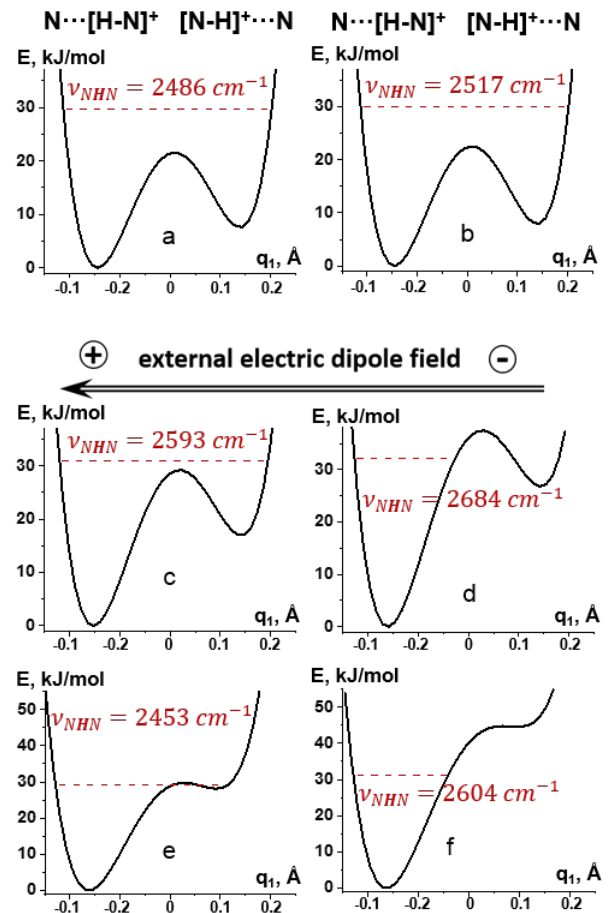
Figure 3. Potential energy curve of a proton transfer within 1 at different approximations: ( a ) PCM ( ε = 29.3), ( b ) SMD (CH 2 Cl 2 , ε = 8.9), ( c ) PCM ( ε = 29.3) and the external electric field of 0.001 a.u., ( d ) PCM ( ε = 29.3) and the external electric field of 0.002 a.u., ( e ) the external electric field of 0.003 a.u., and ( f ) the external electric field of 0.005 a.u. Dashed lines indicate the energy of the ground state. ν NHN are the frequencies of the mobile proton stretching vibration. q 1 corresponds to the distance of the mobile proton with respect to the H-bond center [51].